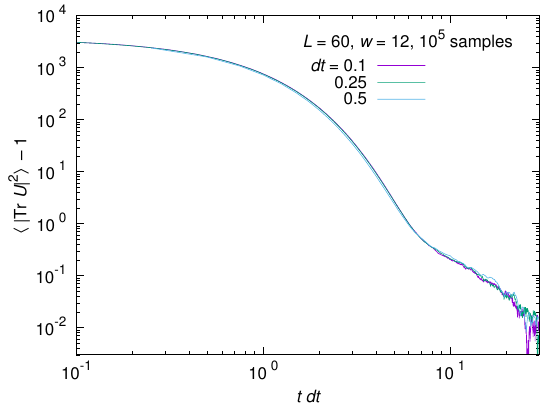
Figure 28 . Plot of hj Tr U j 2 i (cid:0) 1 against t dt for dt = 0 : 1 ; 0 : 25 ; 0 : 5 for Brownian circuits of random band matrices with L = 60 and w = 12. 10 5 samples have been taken for each choice of dt . time for the local Hamiltonian, t (cid:24) N 2 (cid:24) (log L ) 2 (see section 4.2), is much shorter ramp p than ( L=w ) 2 when w (cid:24) L